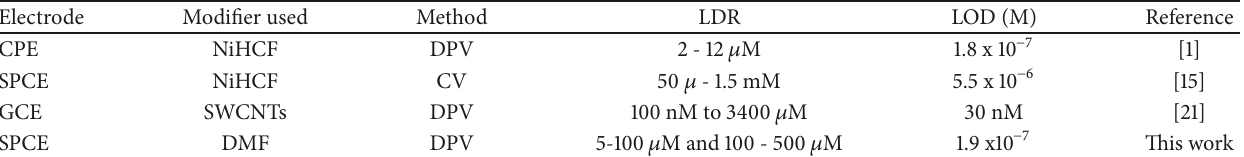
Figure 3: Differential pulse voltammogram of 1 mM uric acid by DMF modified SPCE at a scan rate of 10 mV/s, pulse amplitude of 240 mV, and Pulse period of 100 ms at different pH values (0.1 M). Table 1: Comparison of the electrochemical performance of current sensor with reported